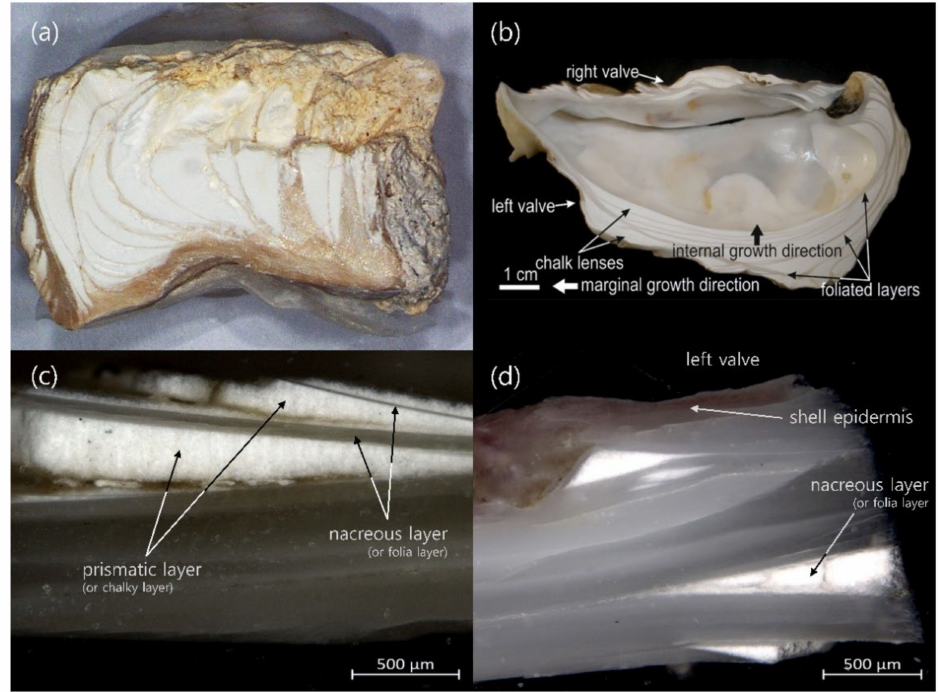
Figure 10. Comparison between the cross-section of shell fragments in plaster and oyster shell: ( a ) Cross-section of shell fragment in plaster. ( b ) Cross-section of oyster shell (Reprinted with permission from Ref. [8]. Copyright 2018, copyright Antonio, G.C et al., licensed under CC-BY 4.0. ( c ) Optical images of cross-sectional shell fragment in plaster. ( d ) Optical images of cross-sectional oyster